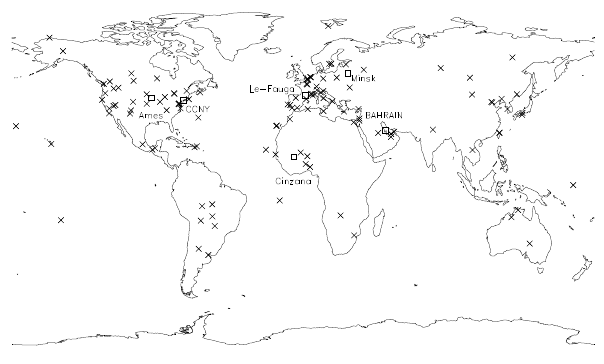
Fig. 1. Location of all surface sites used in this study. Crosses: AERONET sites used for assimilation; blocks: AERONET sites used for validation; The names of the validation sites are also indicated.